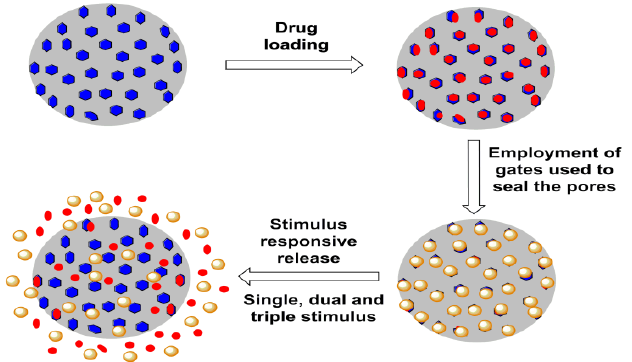
Figure 10. Schematic representation of pore-size-driven drug loading and the stimulus-modulated drug release mechanism from MSNPs. The stimulus-aided release mechanism has proved excellent in improving the efficacy of chemotherapeutic drugs via moderated dosages.